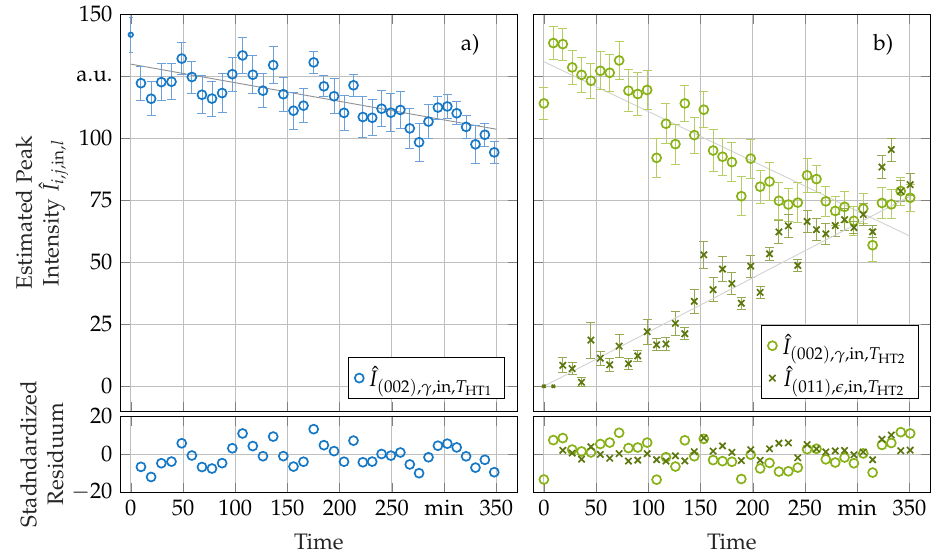
Figure 8. Estimated peak intensities ˆ I i , j ,in, l as acquired by fitting Voigt-functions to the in-situ datasets recorded during HT with XRD of ( a ) sample 1 at T HT1 ( T S ≈ 644 ◦ C) and ( b ) sample 2 at T HT2 ( T S ≈ 732 ◦ C). Additionally given: Graph of the linear model fitted to the estimated peak intensities with smaller marks indicating datapoints excluded from the fit.